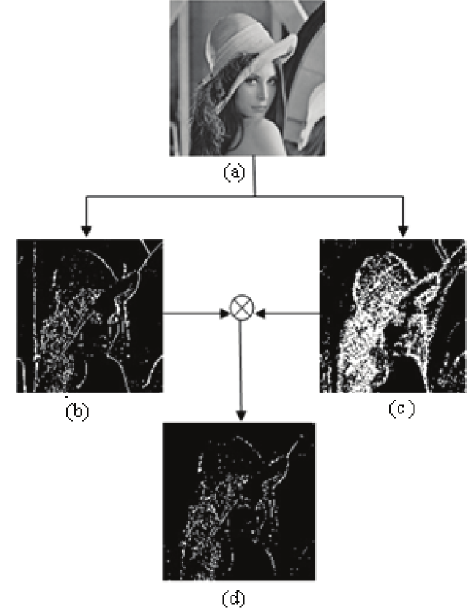
Figure 5: Selection of visually significant Interest points (a)Original Image (b) Canny edge map (c) Wavelet edge map (d) Visually significant feature point map